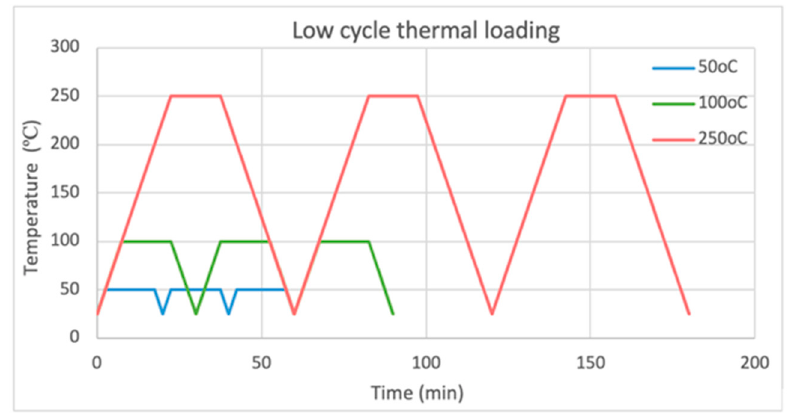
Figure 5. Time–temperature curves for cyclic thermal loading of max 3 cycles under constant tensile load (heating process, holding time 15 min at 50, 100 and 250 °C, cooling process to RT = 25 °C).